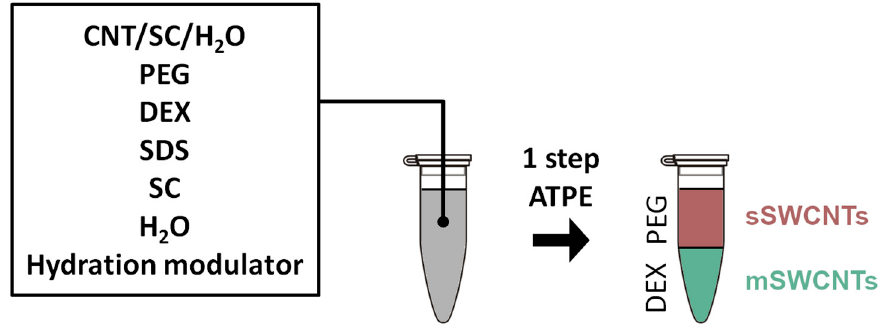
Figure 1. The method of separation used in the study—one-step aqueous two-phase extraction (ATPE), which, in this case, gives s-SWCNTs (semiconducting single-walled CNTs) and m-SWCNTs (metallic single-walled CNTs).